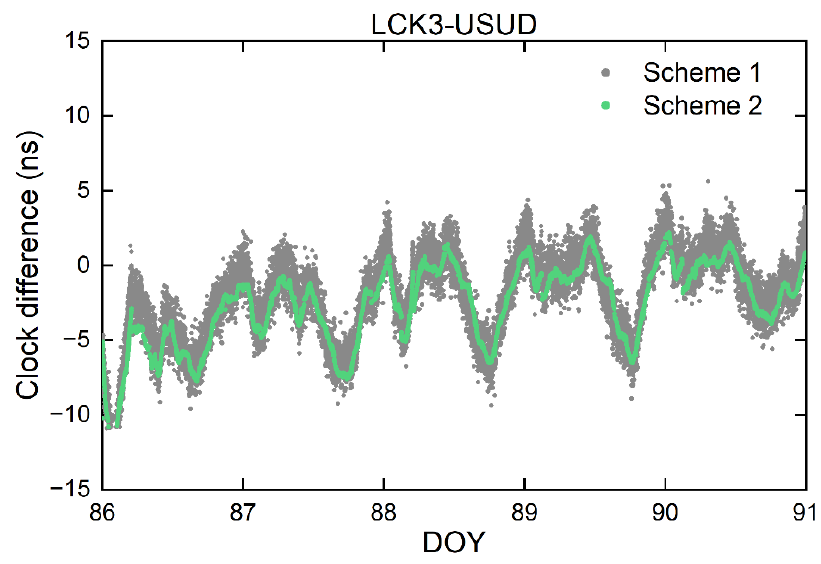
Figure 10. Clock difference of the SF SPP time transfer for the LCK3-USUD time link.